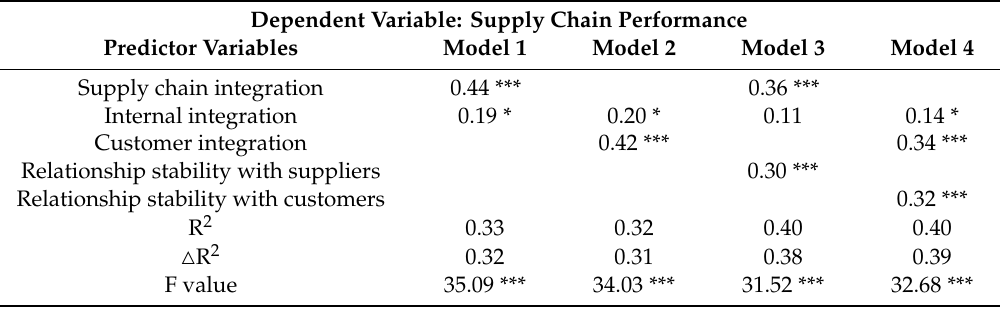
Table 6. Mediating e ff ect of relationship stability.